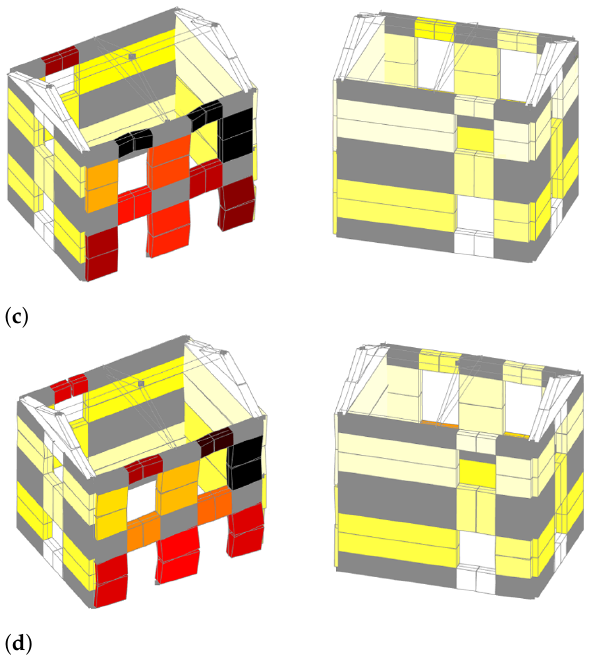
Figure 13. Deformed shapes and maximum element drifts in flexure and shear (magnification factor × 10): ( a ) Unretrofitted. ( b ) Diaphragms retrofitted. ( c ) Connections retrofitted. ( d ) Both retrofitted.